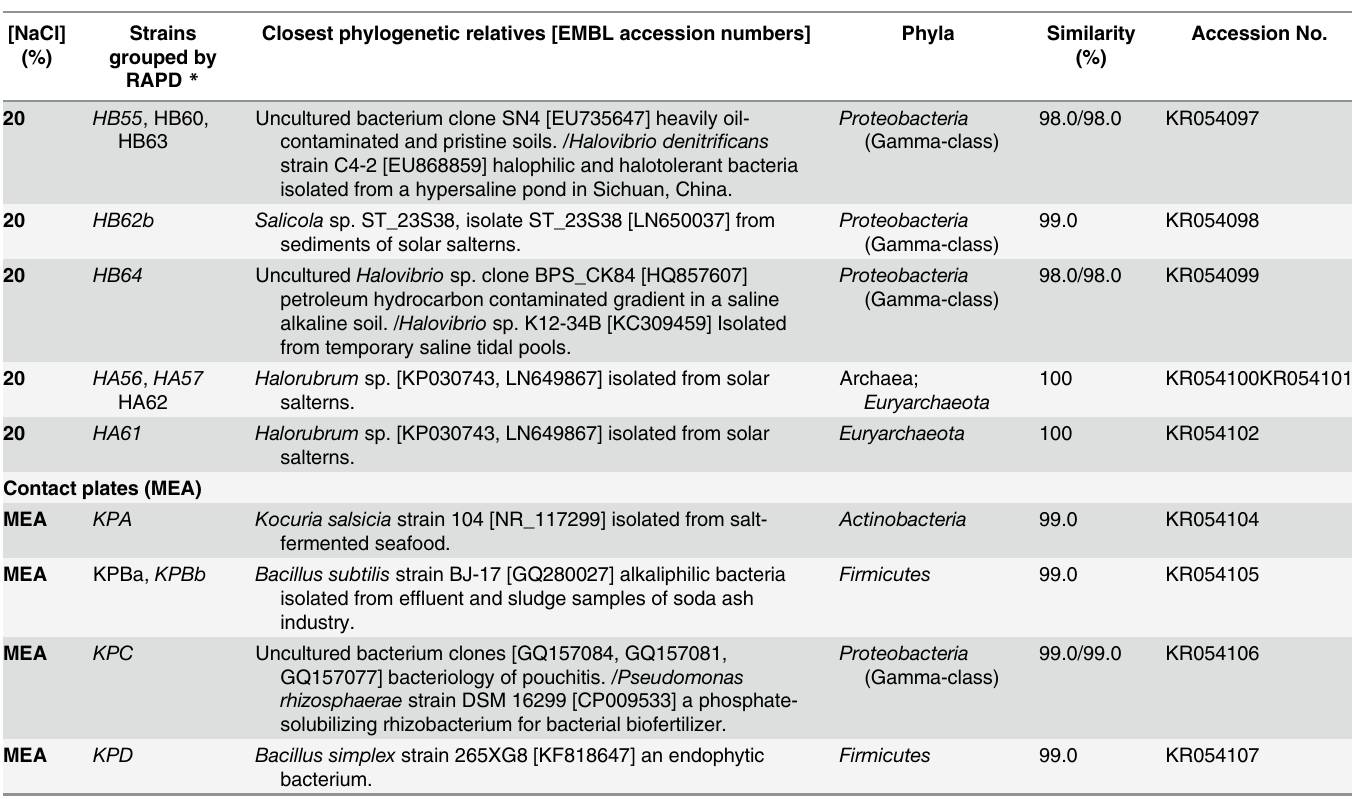
Gels were run at a constant temperature of 60°C with a voltage of 200 V for a period of 3.5 h for Bacteria and Archaea, and 5 h for fungal fingerprints. The linear chemical gradient of dena- turants used in this study [100% denaturing solution contains 7 M urea and 40% (v/v) formam- ide] was 30 – 60% for the screening of Bacteria and Archaea, and 20 – 50% for the screening of fungal communities. After completion of electrophoresis, gels were stained in a 1 μ g ml -1 ethid- ium bromide solution [stock: 10 mg ml -1 ] for 20 min and afterwards visualized by a UVP docu- mentation system (Bio-Rad Transilluminator, Universal Hood; Mitsubishi P93D-printer). Creation of clone libraries, DGGE-screening and Sequencing analyses For the construction of clone libraries, 2×3 μ l DNA templates of each sample were amplified in 2×50 μ l reaction volumes using the universal primers 341f/985r, ARC344/ARC915 and ITS1/ ITS4 for the bacterial, archaeal and fungal DNA amplification, respectively, as mentioned above. The PCR products were purified using the QIAquick PCR Purification Kit Protocol O water. Subsequently, a volume of (Qiagen, Hilden, Germany) and re-suspended in ddH 2 5.5 μ l of the purified PCR product was ligated into the pGEM-T easy Vector system (Promega, Mannheim, Germany) following the manufacturer's instructions. The ligation products were transformed into One Shot TOP10 cells (Invitrogen). The identification of recombinants was performed as previously described by Sambrook et al .